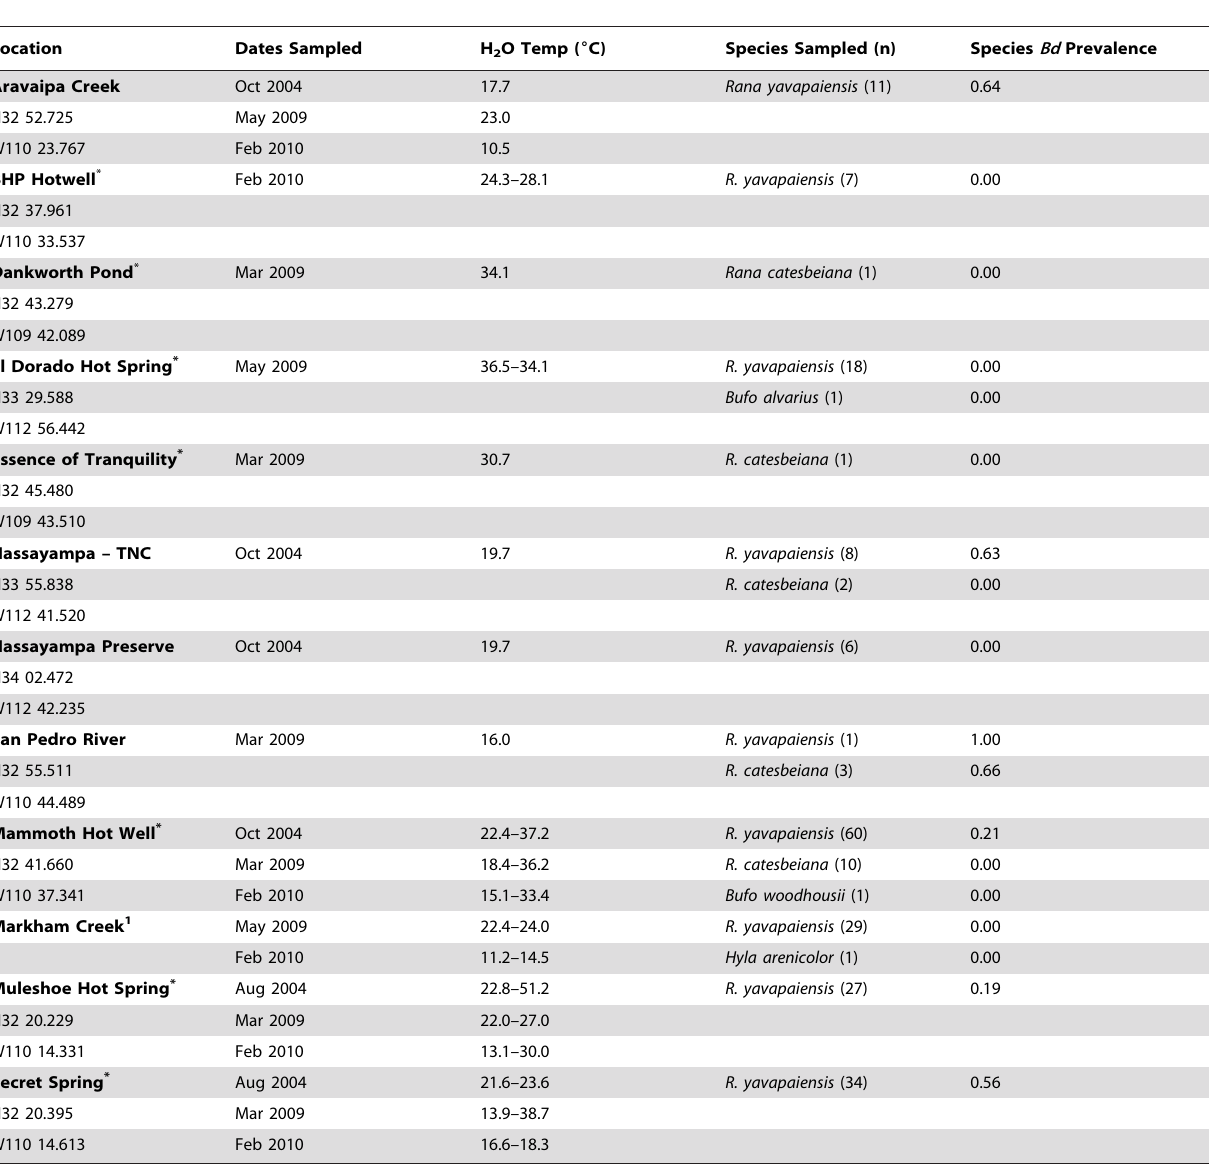
*Indicates presence of a geothermal source at location. 1 Coordinates excluded at the request of U.S. Bureau of Land Management (Safford,